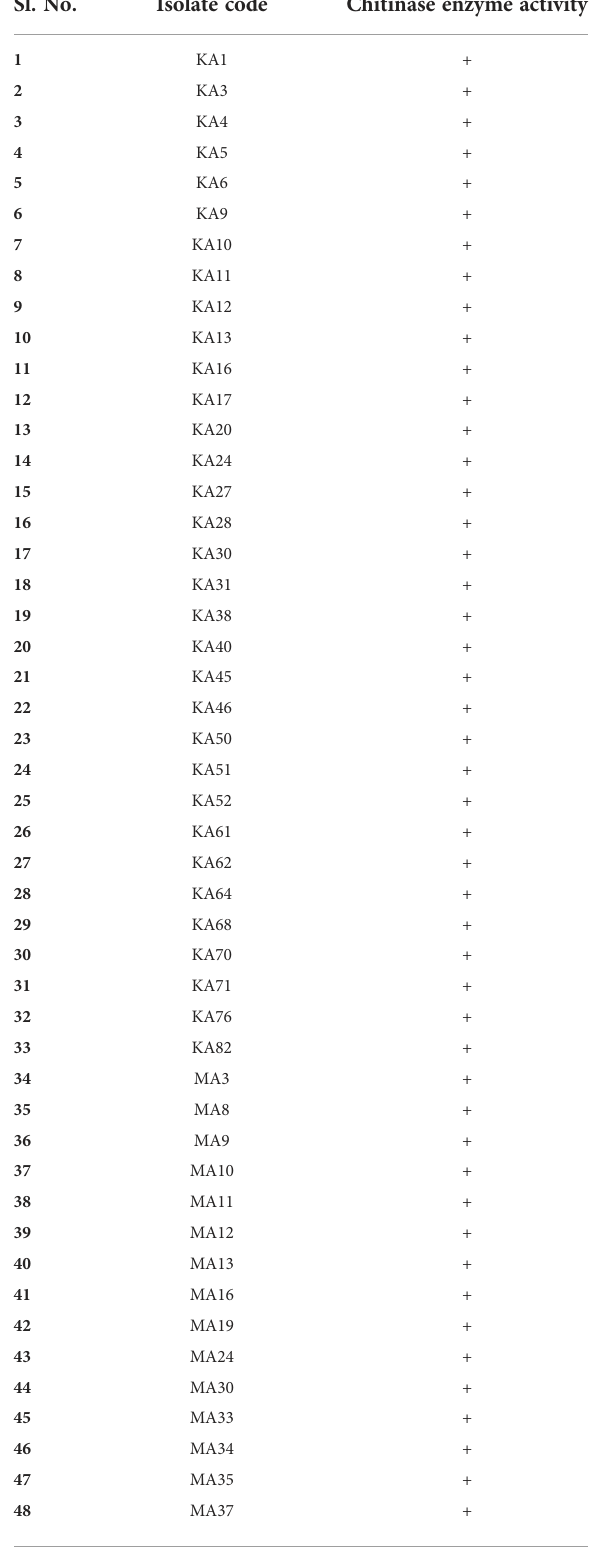
TABLE 3 Isolates showing chitinase enzyme activity. Sl. No. Isolate